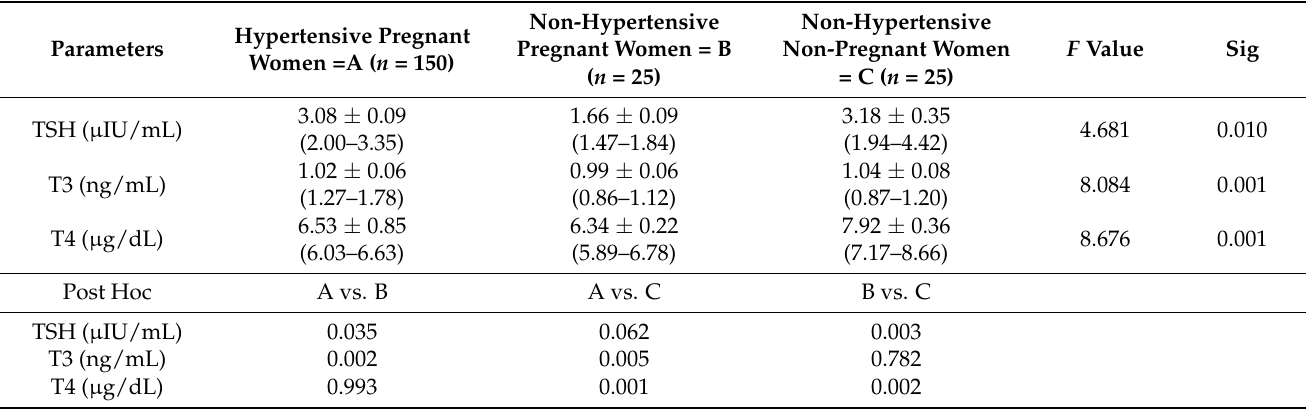
Table 2. Thyroid hormone levels among hypertensive pregnant women, non-hypertensive pregnant women and non-hypertensive non-pregnant women.